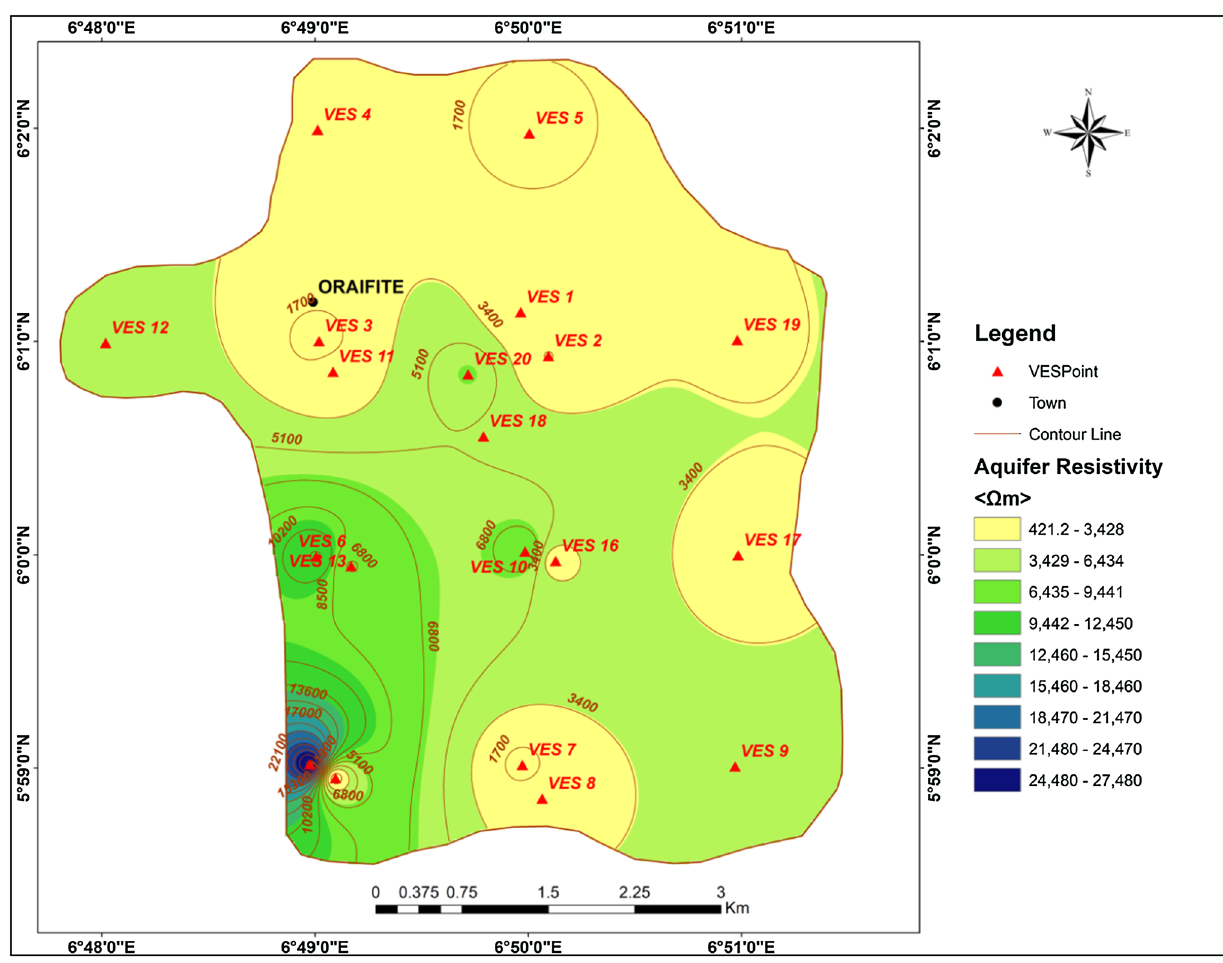
Fig. 4 Contour map of aquifer resistivity showing its distribution in the study